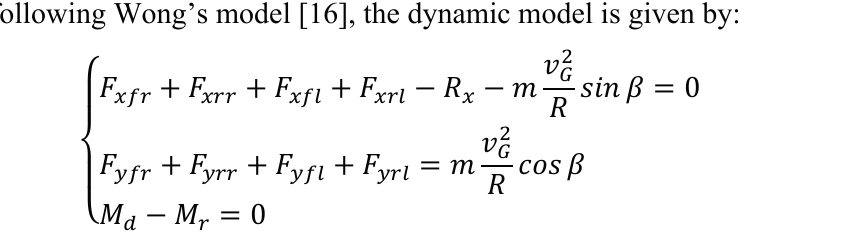
Figure 3. Forces and moments acting on a wheeled skid-steering vehicle during a steady state